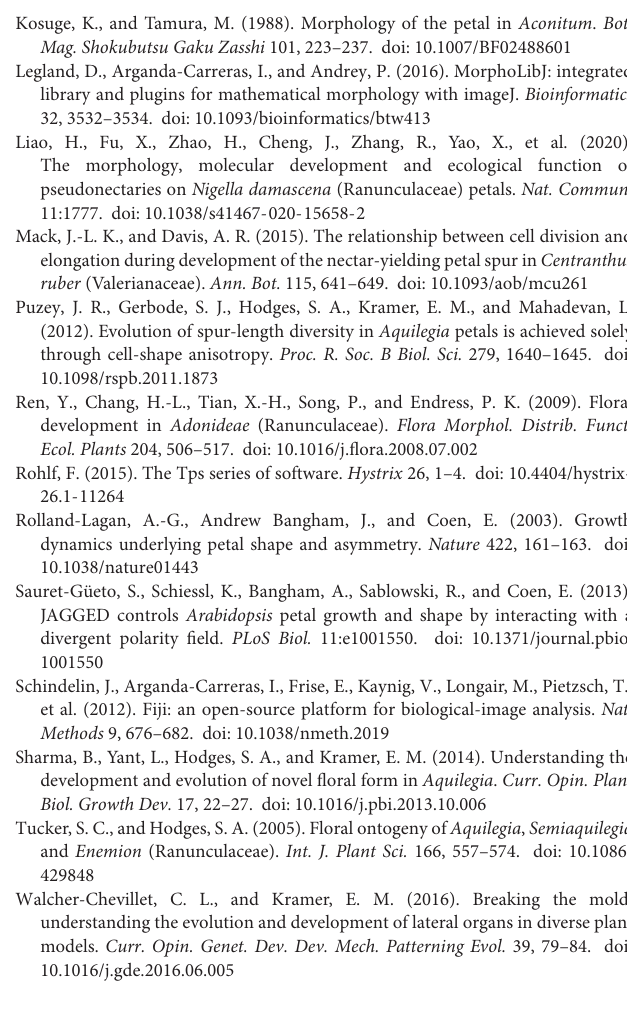
Supplementary Figure 1 | The sequence of cell maps colored by cell area or cell elongation values. Cell maps for cell area (A) and cell elongation (B) are ordered from top left to bottom right in increasing total surface. For every individual, a common color code has been used to make easier comparisons between stages. Supplementary Figure 2 | Resamplings confirm the presence of an allometric law between shape and size during nectar pouch development. PC1 plots against centroid size (A,C,E) or log centroid size (B,D,F) after original sampling (characterized by an oversampling of smallest petals), equilibrate resampling (i.e., individuals regularly spaced on the size scale), and oversampling of largest petals. An exponential relation is found for every case, excluding a sampling bias and consolidating its biological origin. Supplementary Figure 3 | Cell characteristics (mean size and number) during development. (A) Cell number plotted against nectar pouch surface (mm 2 ). (B) Mean cell size ( µ m 2 ) plotted against cell number shows a stasis phase of mean cell size (compatible with a proliferation phase), which ends with a sharp increase in cell mean size (compatible with an expansion